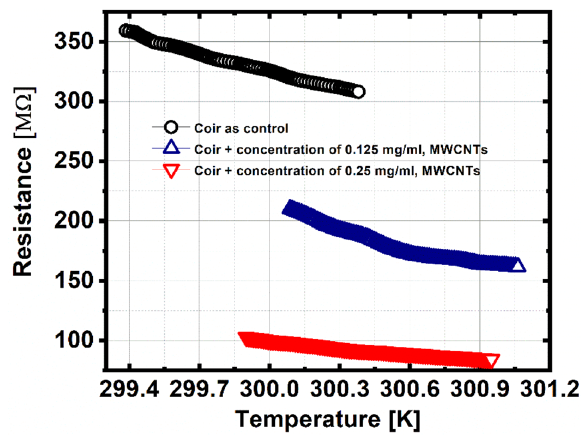
Figure 2. Electrical resistance as a function of temperature.